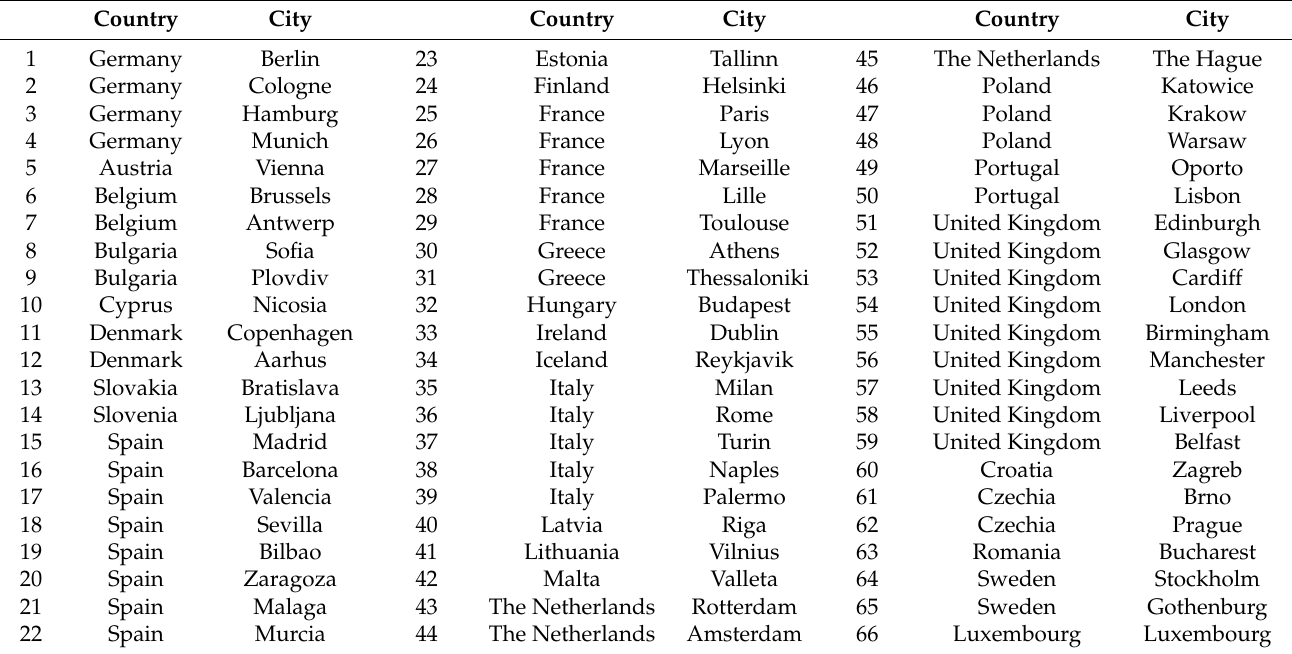
Table 1. European